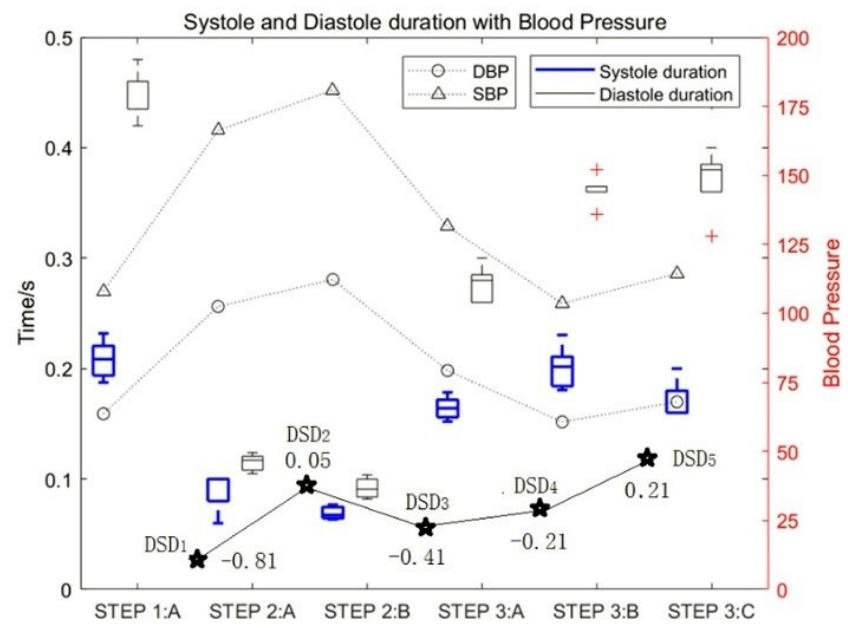
Figure 6. The influence of motion on the duration of diastolic and systolic heart sounds and the DSD values.